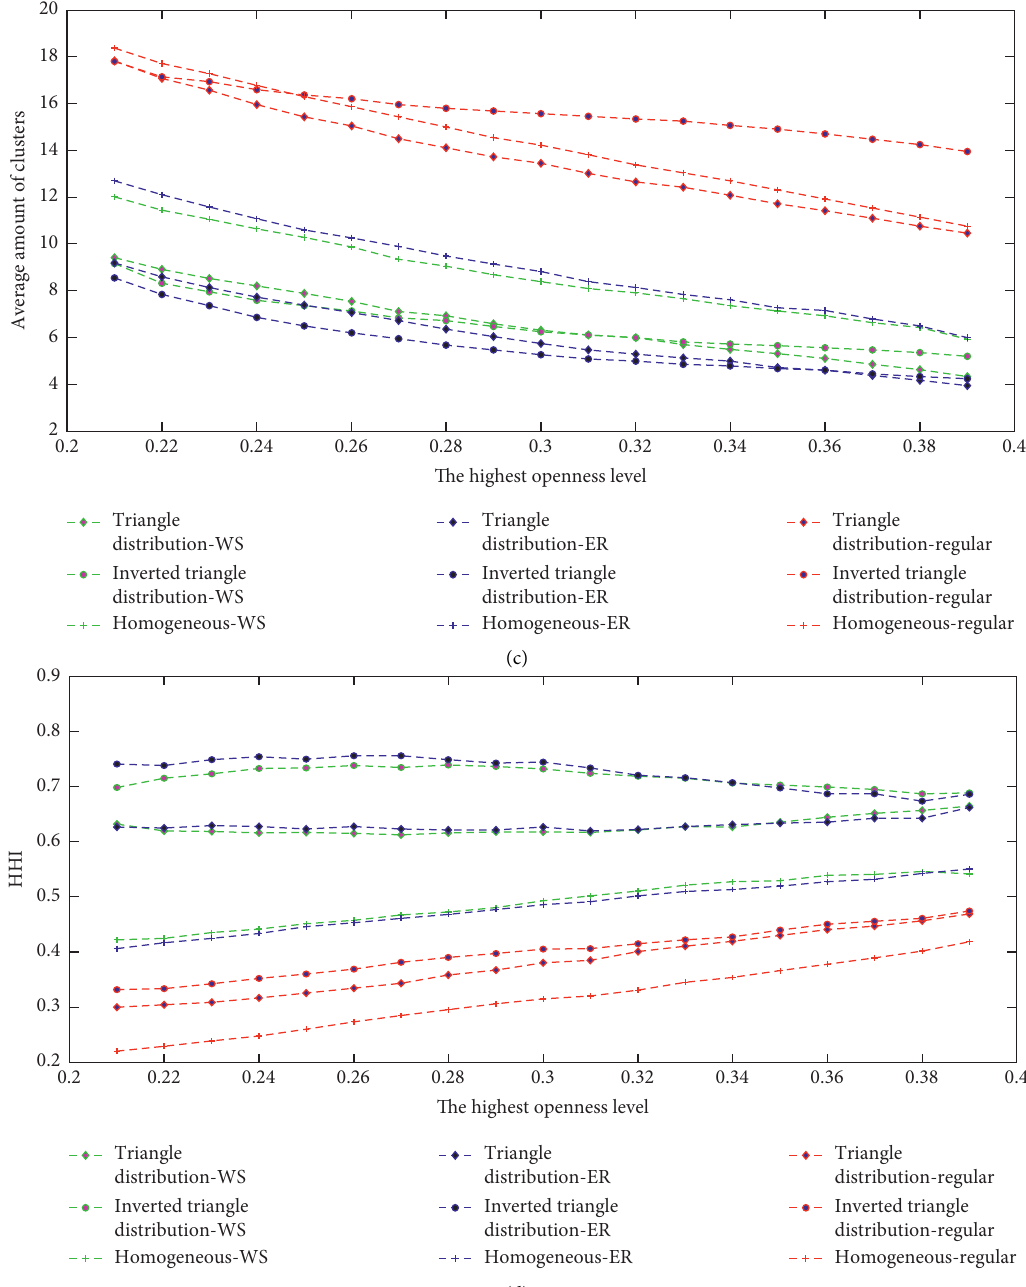
Figure 5: Influence of the lowest openness level or the highest openness level on the AOC and